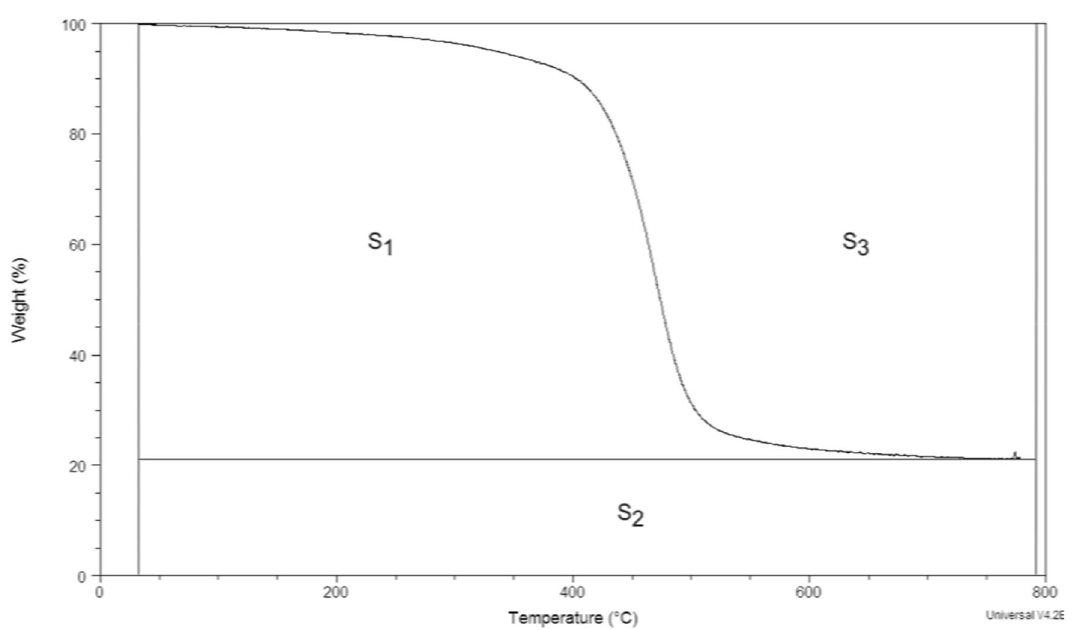
Fig. 6 Graphical procedure to determine the IPDT